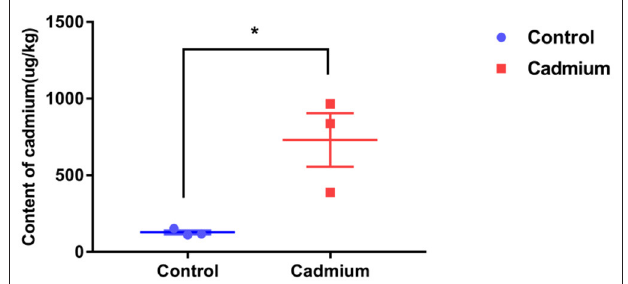
FIGURE 1 | The content of cadmium in liver tissues. Cadmium content in the liver tissues of the control group (Control) and cadmium-treated group (Cadmium), as obtained by graphite furnace atomic absorption spectrophotometry ( µ g/kg). Data were analyzed by independent samples t -test. The significance level was set at * p < 0.05.